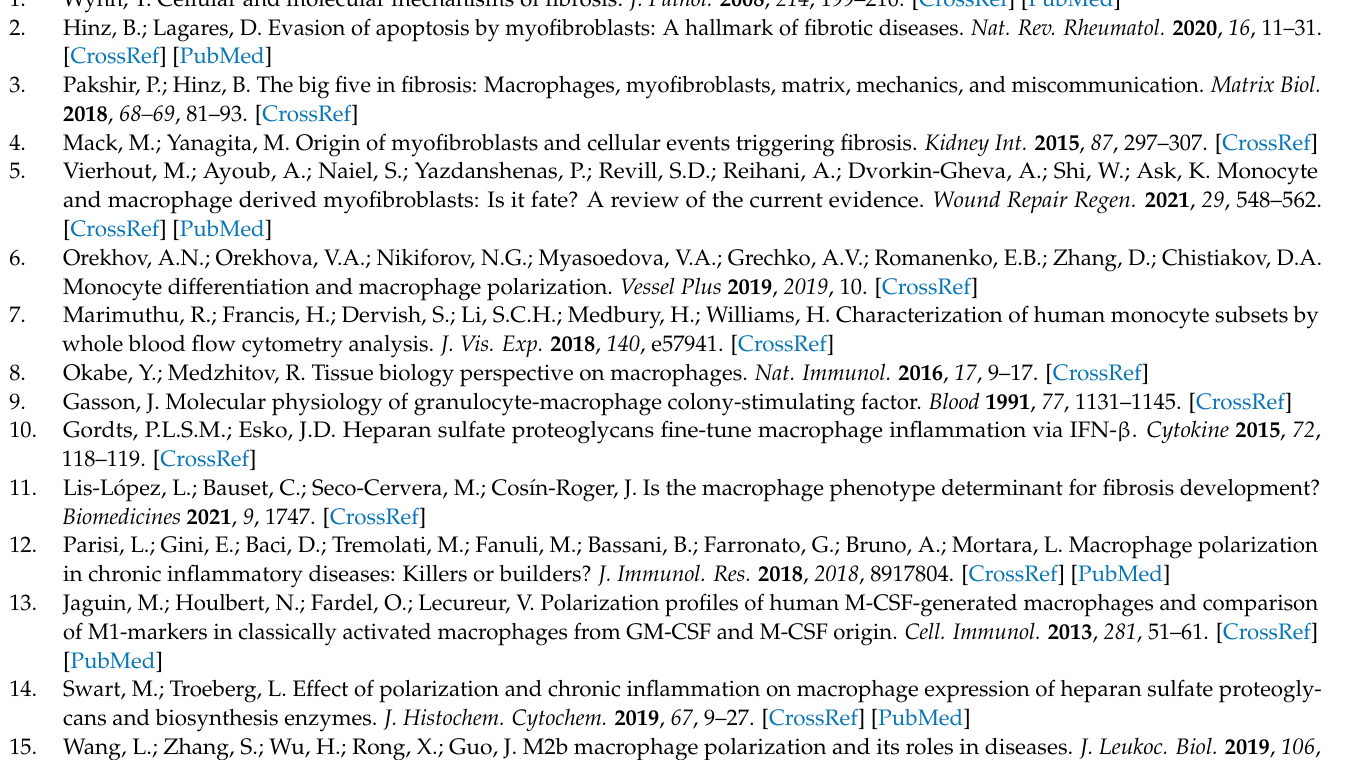
Figure A3. Gene expressions of polarized human monocyte-derived macrophages. Negatively selected monocytes (n, sample = 3; n, biological = 2; n, technical = 3) were differentiated to macrophages using M-CSF or GM-CSF (highlighted in grey). After 6 days, M Φ were stimulated with IFN- γ /LPS (M1), IL-4 (M2), or with no additive (M0). Cells were harvested after a polarization time of 48 h. The relative gene expressions of ( A ) IL1B , ( B ) IL8, ( C ) HSPG2 and ( D ) SDC2 were determined using qRT-PCR. The data were analyzed using a one-way ANOVA, followed by Tukey’s multiple comparison tests, and expressed as mean ± SEM. ns (not significant), p < 0.05 (*), p < 0.01 (**), p < 0.001 (***), p < 0.0001 (****).